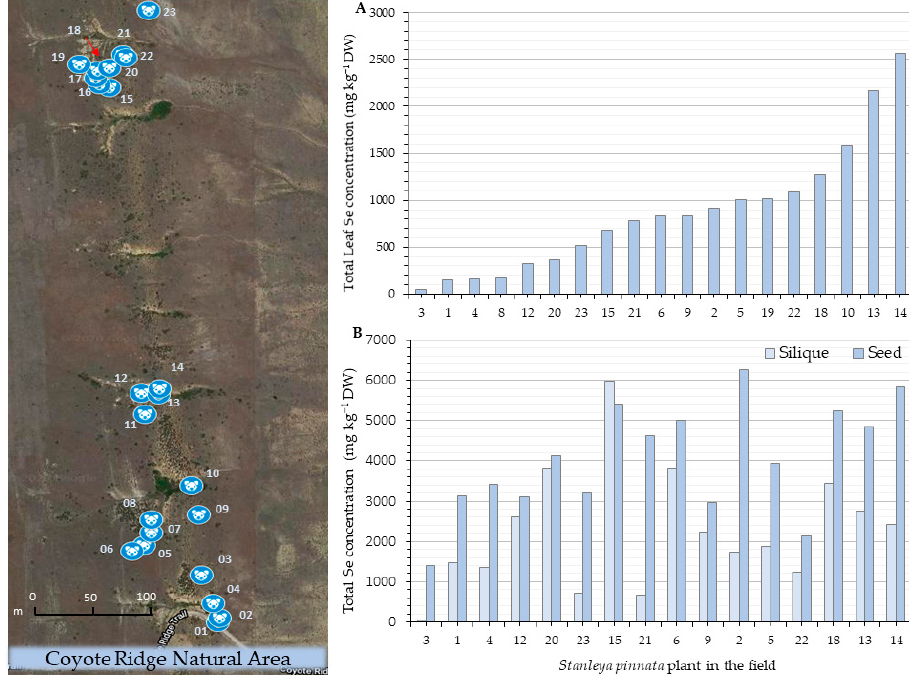
Figure 2. Stanleya pinnata plant locations at the Coyote Ridge natural area ( left ) and tissue Se concentrations ( right ). The numbers on the horizontal axis represent the collection numbers of each plant. ( A ) Leaf Se concentration of individual plants, ordered according to their Se levels. ( B ) Silique and seed Se concentration of the same plants, where the numbering was maintained for consistency.